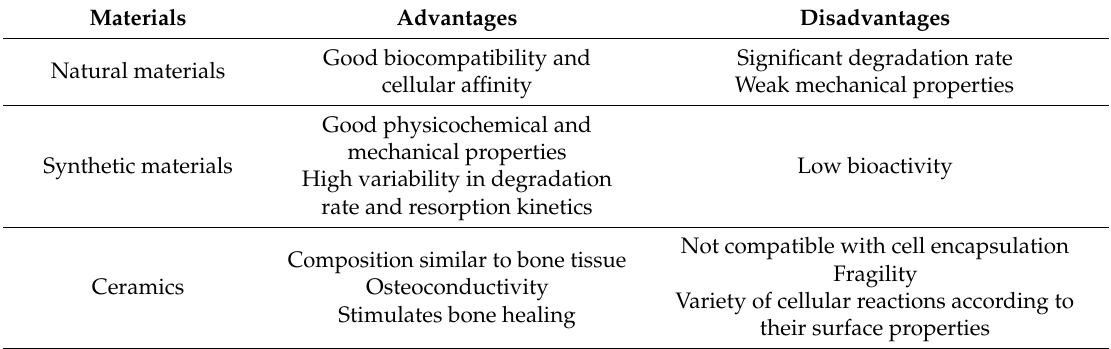
Table 1. Advantages and disadvantages of the di ff erent materials used for periodontal regeneration.